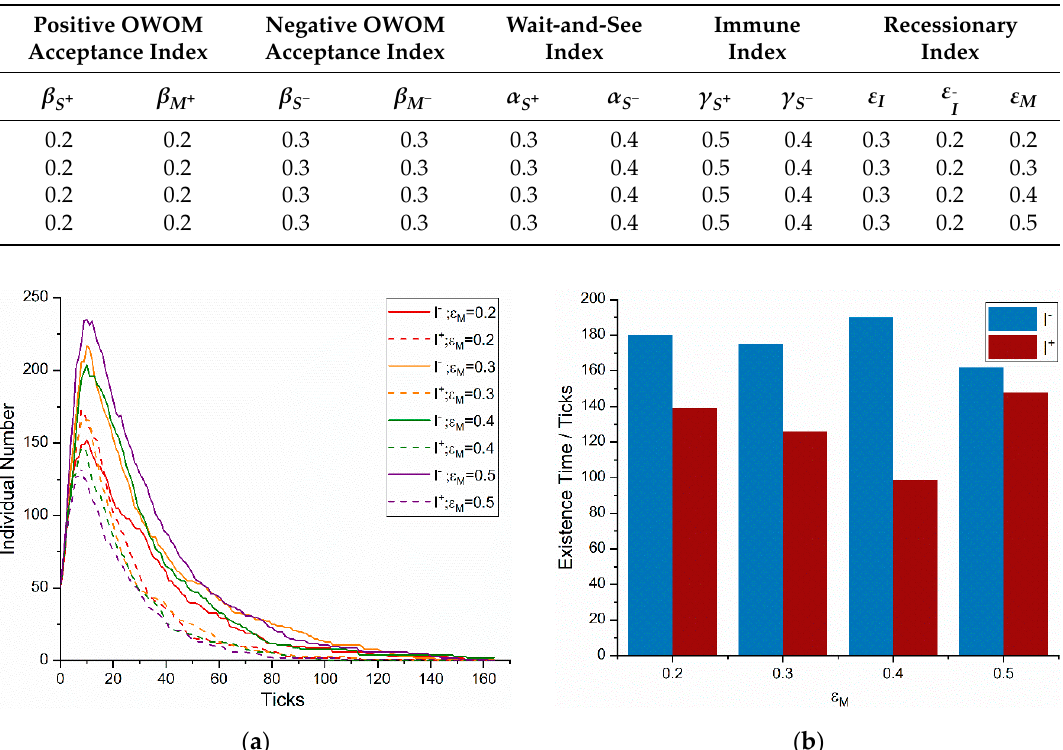
Table 9. Simulation Experiment 6 parameter setting.